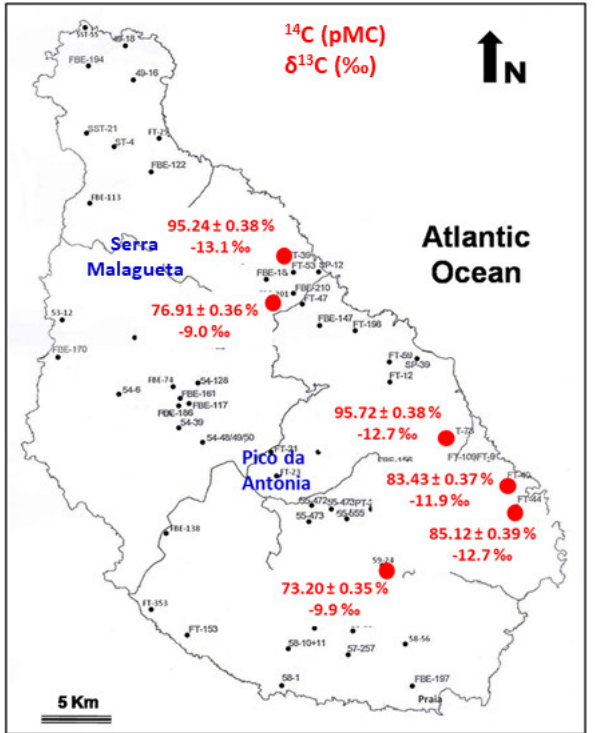
Figure 14. Map of Santiago Island. Location of the groundwater samples with carbon-14 data.